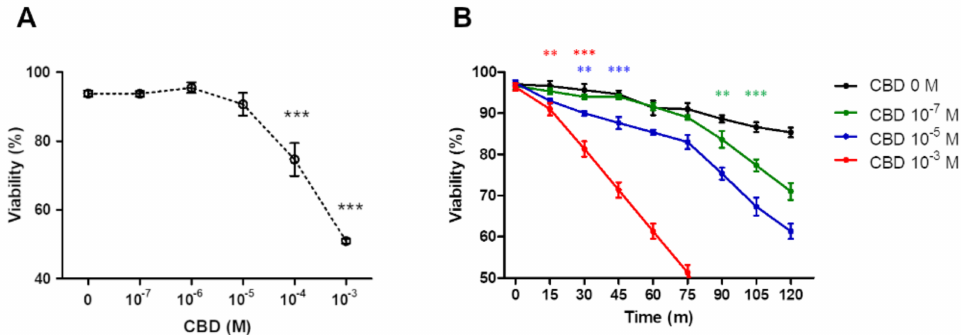
Figure 1. CBD affect the viability of PMNs. PMNs viability is significantly affected with CBD concentrations >10 − 5 M ( A ) and correlated with shorter survival time courses at the same CBD concentrations ( B ). Results are expressed as mean ± SD ( p < 0.05). ** and *** indicate the significance differences relative to 0 M of CBD. In ( B ) the asterisks indicate the point from which the curves for each CBD concentration are different from the control, while the color of the asterisks indicates which CBD concentration is